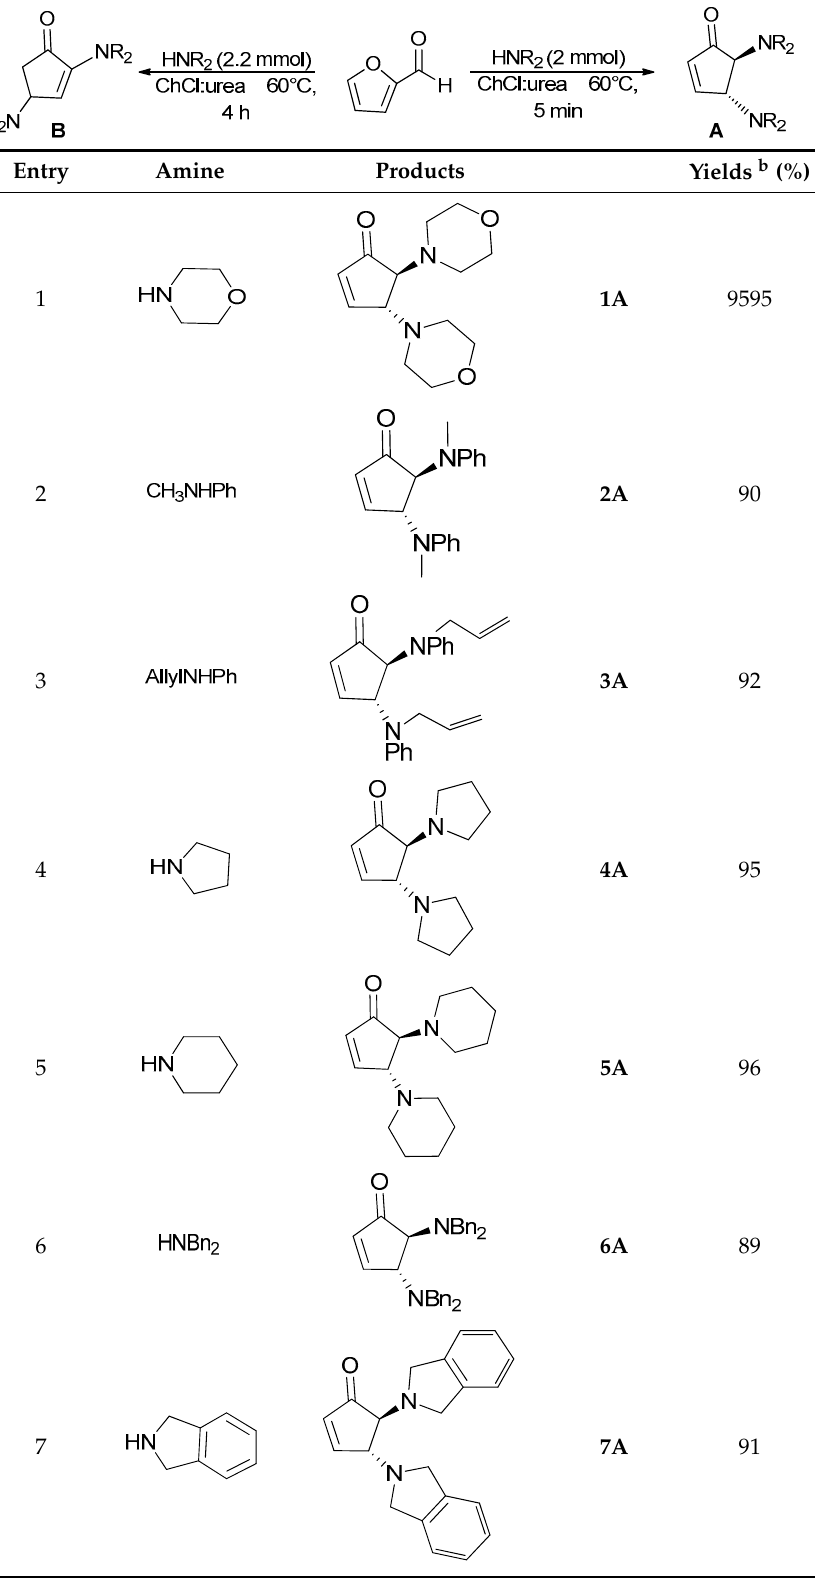
Table 2. Synthesis of bifunctionalized cyclopentenones from furfural a .